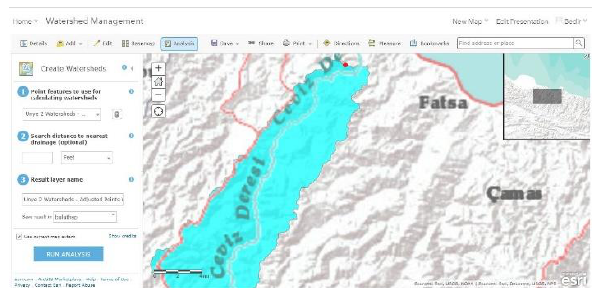
Figure 2: First watershed analysis